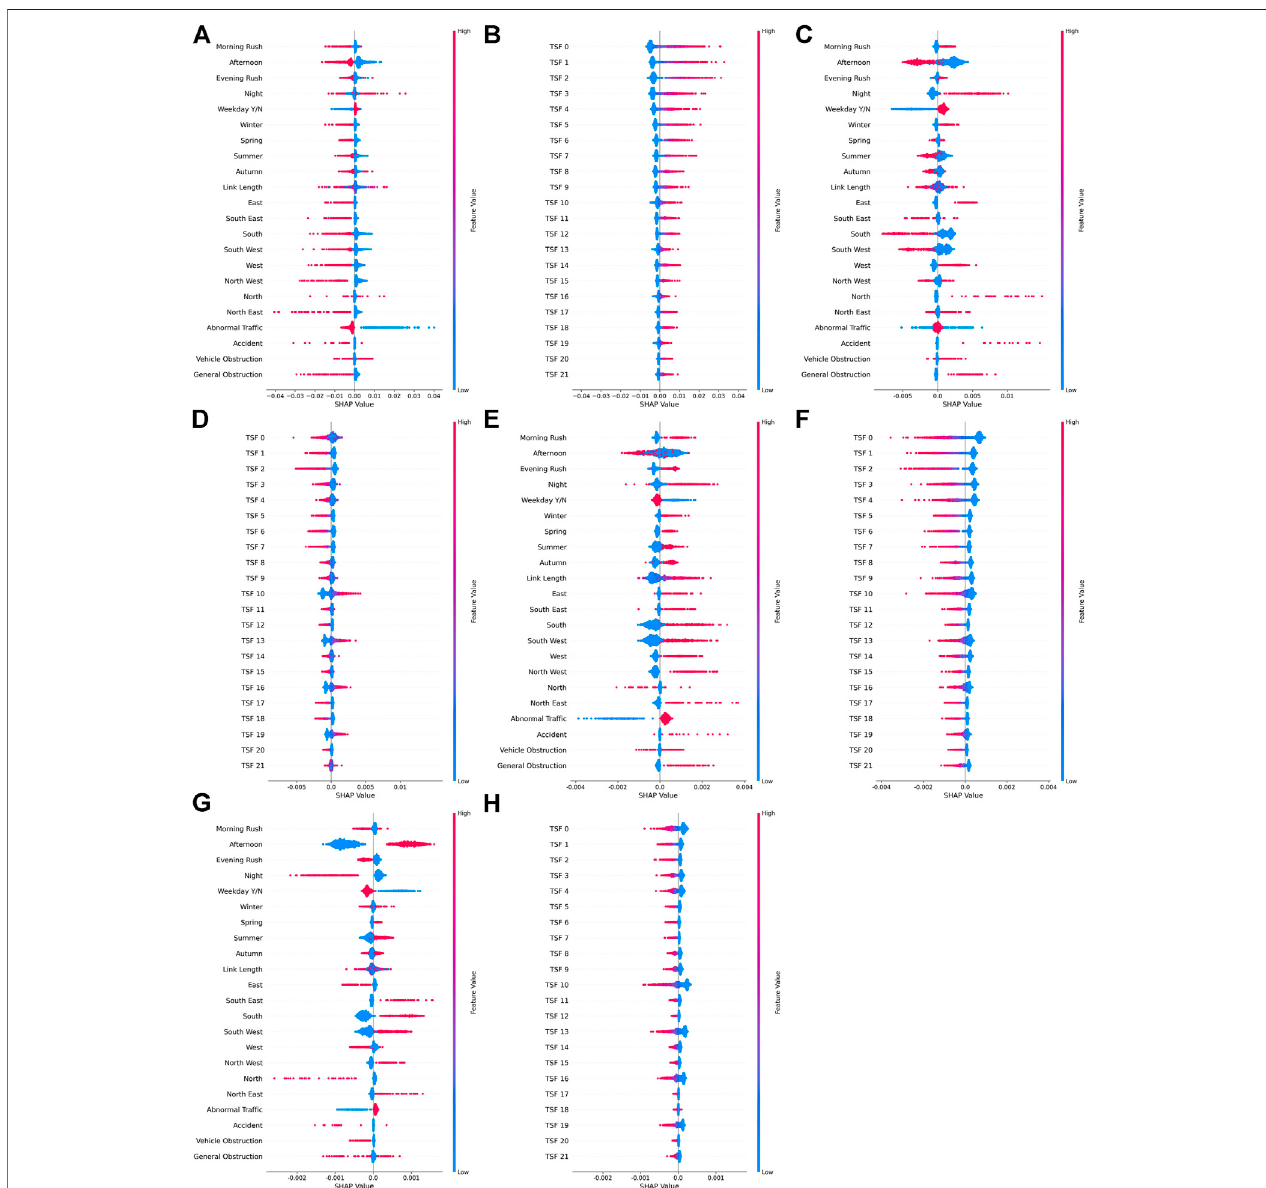
FIGURE6| SHAP valuesvisualizinghowfeaturevaluesshifttheoutputofthenetworkatparticular horizons h . (A) :Time-invariantfeatures, h (cid:2) 5. (B) :Time-varying features, h (cid:2) 5. (C) :Time-invariantfeatures, h (cid:2) 30. (D) :Time-varyingfeatures, h (cid:2) 30. (E) :Time-invariantfeatures, h (cid:2) 60. (F) :Time-varyingfeatures, h (cid:2) 60. (G) :Time- invariant features, h (cid:2) 180. (H) : Time-varying features, h (cid:2) 180.